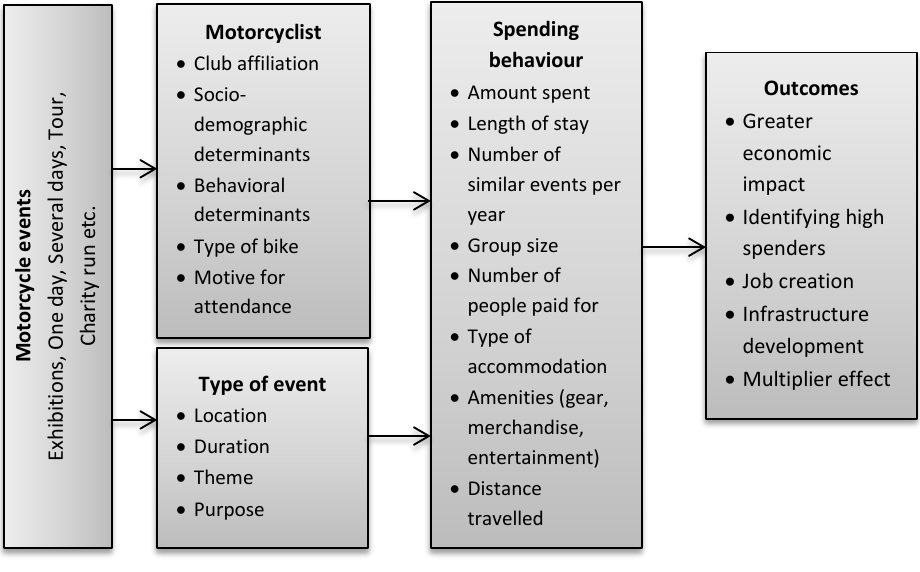
FIGURE 1: Outcome based analysis of motorcycle events Source: Authors’ illustration based on available